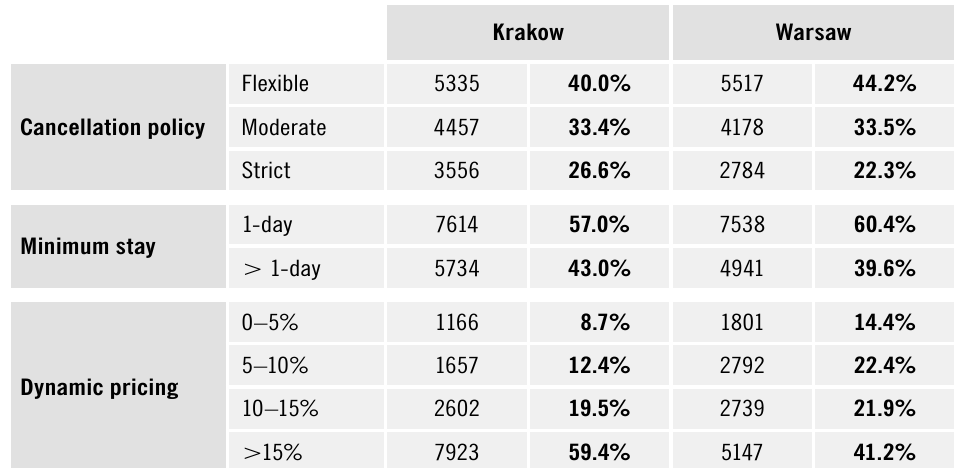
Table 4. Revenue management practices by city